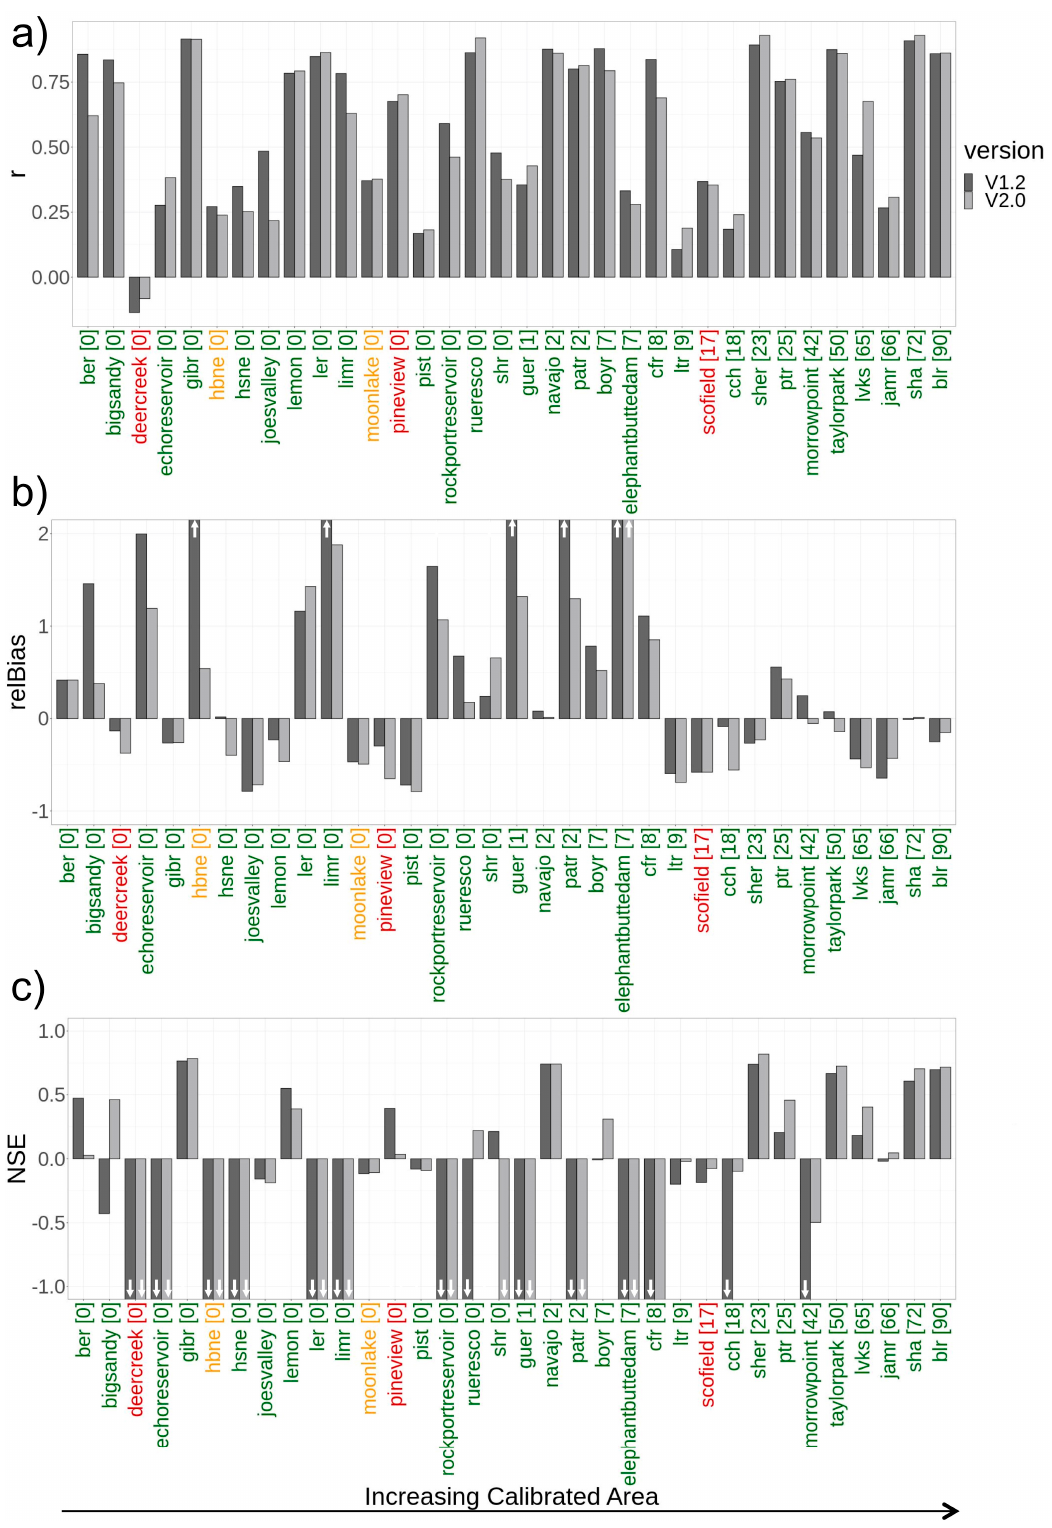
Figure A1. Goodness of fit scores from the NWM v1.2 (dark grey) and NWM v2.0 (light grey) retrospective total inflow evaluation, ordered by increasing calibrated area. From top to bottom: r ( a ), relBias ( b ) , NSE ( c ).